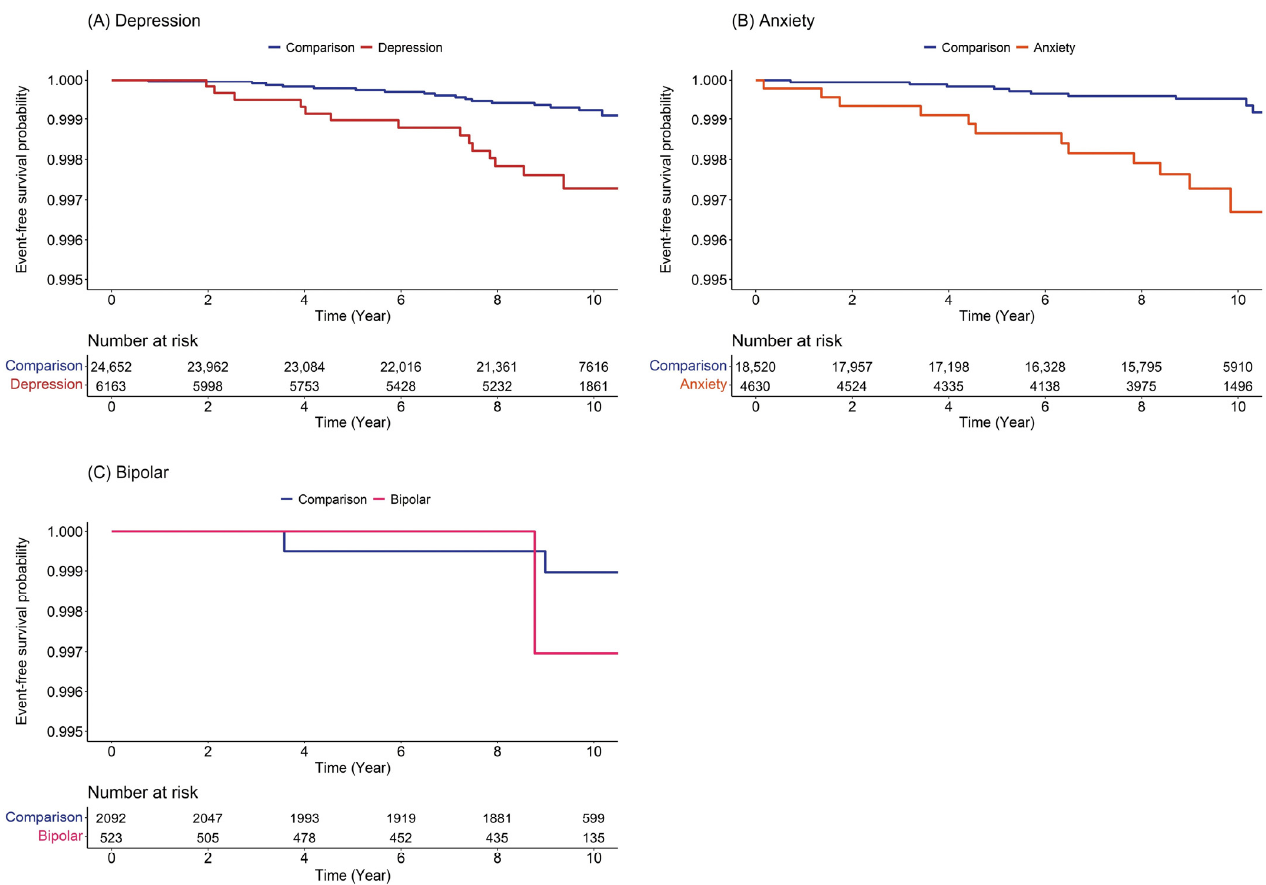
Figure 3. Burning mouth syndrome-free survival probability of burning mouth syndrome in patients with ( A ) depression, ( B ) anxiety, and ( C ) bipolar.